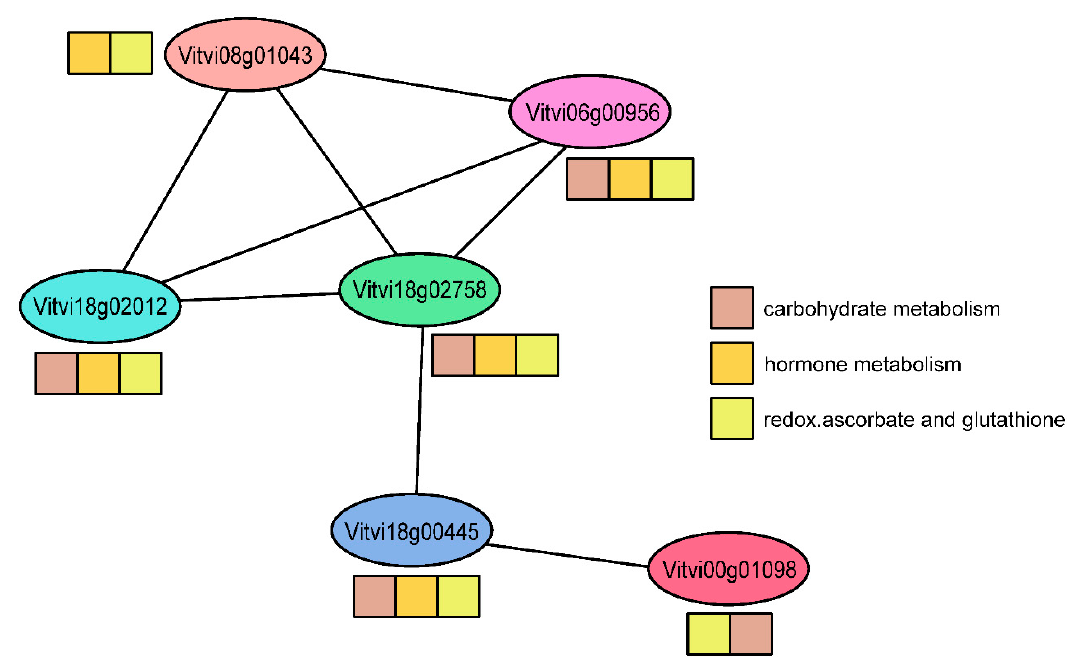
Figure 6. A community of six genes associated with three different metabolic processes correspond to Community 2 in Table 1. The coloured squares indicate gene-process associations.